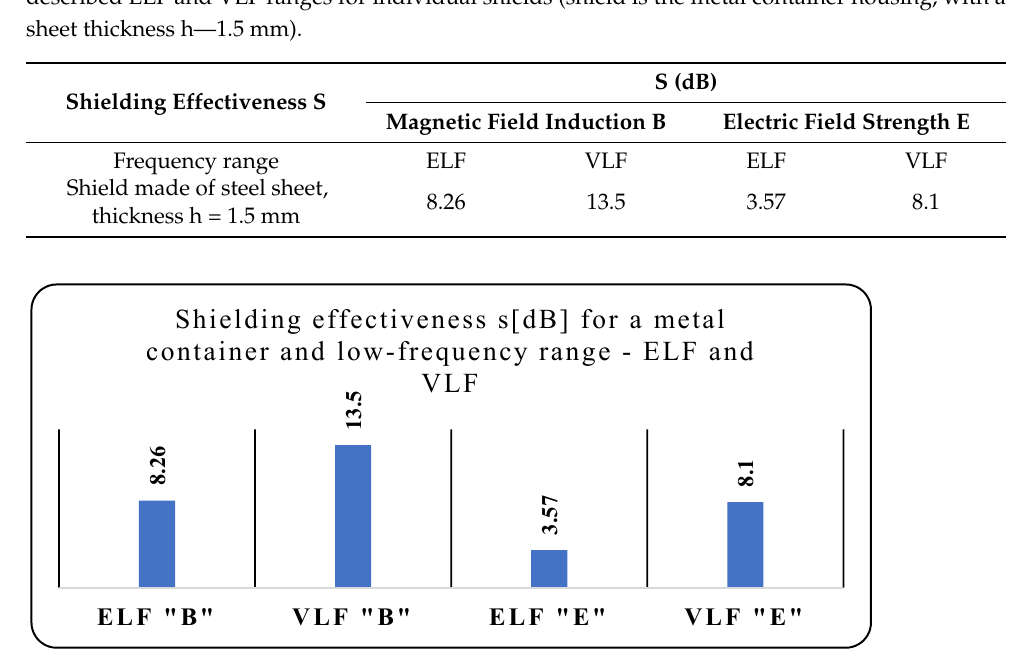
Figure 18. Shielding effectiveness for a metal material with a thickness h = 1.5 mm, for magnetic field induction B and electric field strength E, over the ELF and VFL ranges.